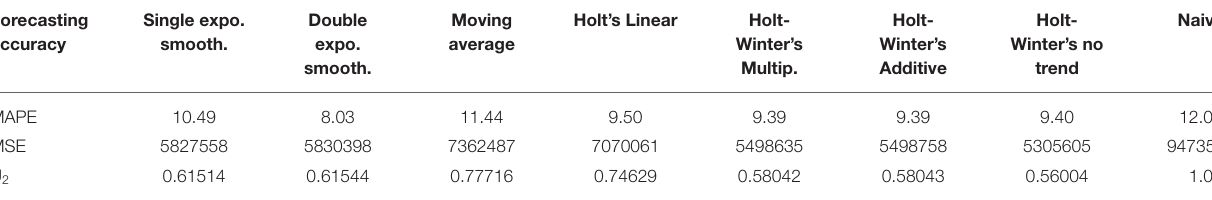
TABLE 5 | The results of forecasting (second approach and product without shortage). Forecasting accuracy